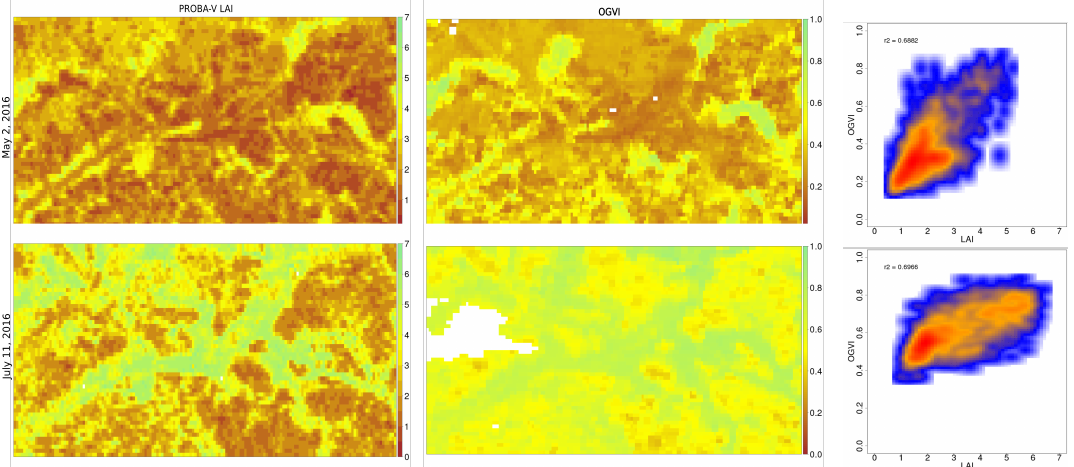
Figure 10. PROBA-V LAI (300 m resolution), OLCI Global VI (OGVI) and a scatterplot of both variables over the upper Biebrza basin, Poland, on 2 May 2016 and 11 July